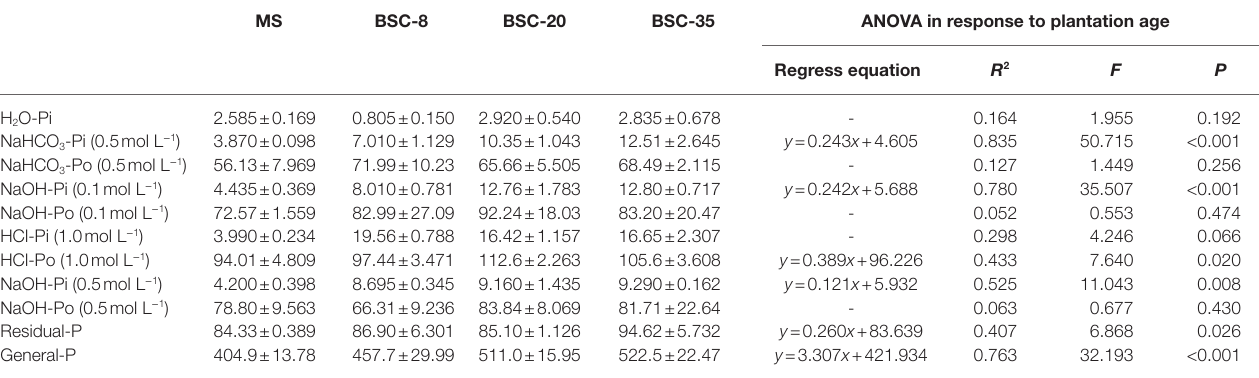
TABLE 2 | Fractions of soil P in an age sequence of soil crusts under plantations (mg kg − 1 ).